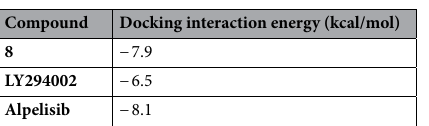
Table 5. Docking interaction energy of compound 8 against